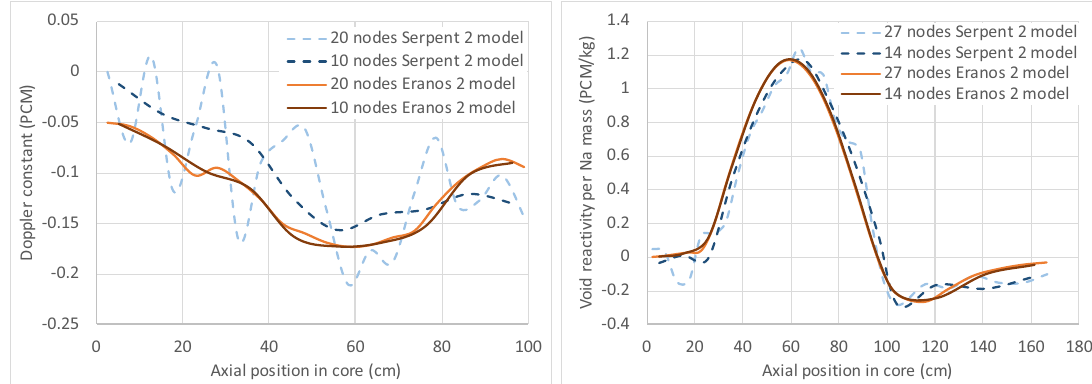
Figure 5. Doppler constant (left) and void reactivity (right) distribution along the axial height. The void reactivity per batch can be simulated by Serpent code for 8 axial nodes in each assembly, providing still reasonable values. ERANOS can simulate both the Doppler constant and void reactivity distribution with the same accuracy for respectively 20 and 28 axial nodes in each fuel batch.